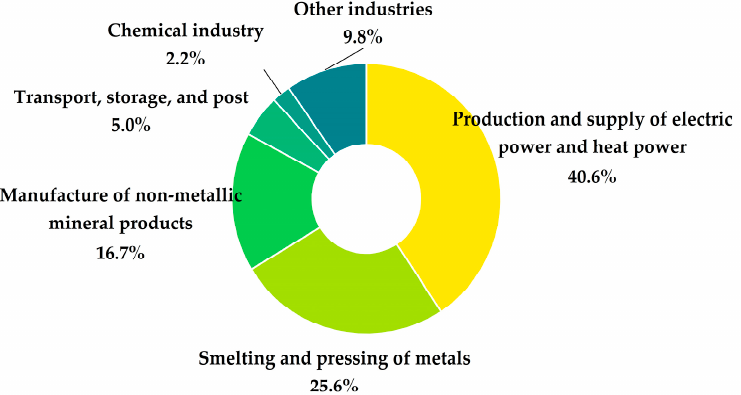
Figure 15. The average share of embodied emissions contributed by various industries.